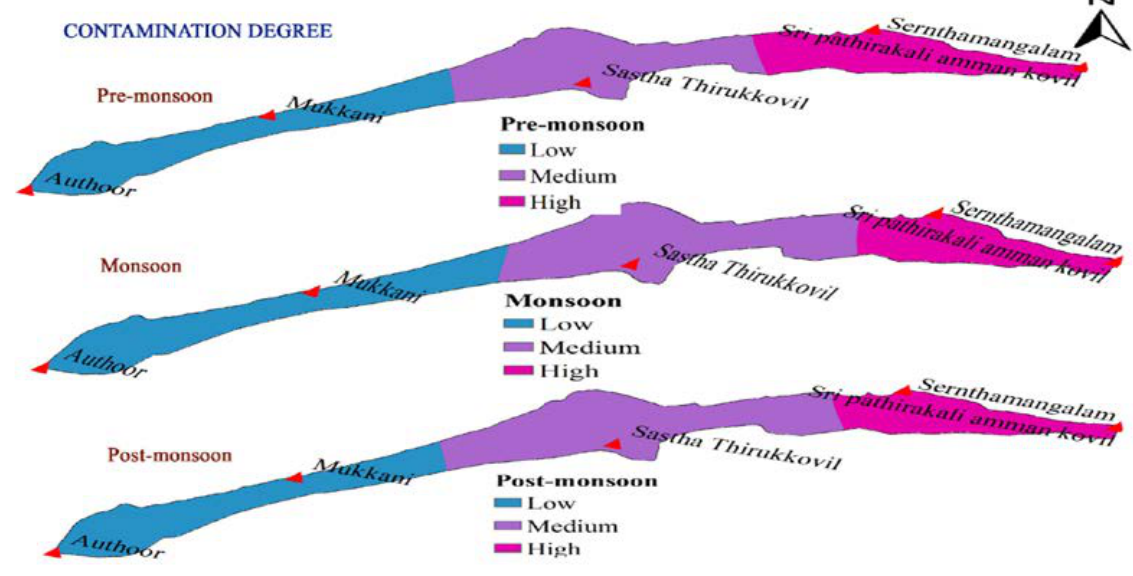
Fig. 6: Contamination degree in sediments during various seasons